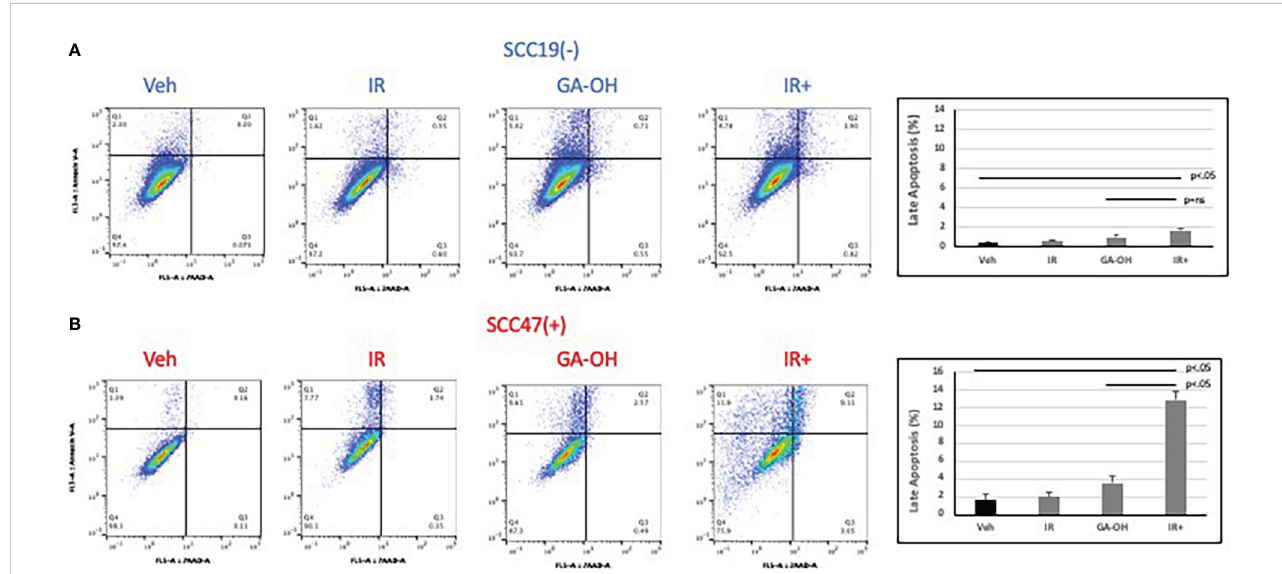
FIGURE 8 Apoptotic induction after radiation and GA-OH treatment using fl ow cytometry. SCC19 (A) and SCC47 (B) cells treated with or without GA-OH were stained with Annexin V and 7AAD 24 hours post-irradiation and analyzed using fl ow cytometry. SCC47 showed greater apoptotic induction compared to SCC19 particularly in the combination setting. Graphical representation shows quanti fi cation of apoptotic cells that are double stained after 24 hrs. Values shown represent means ± standard deviation from 3 independent experiments.